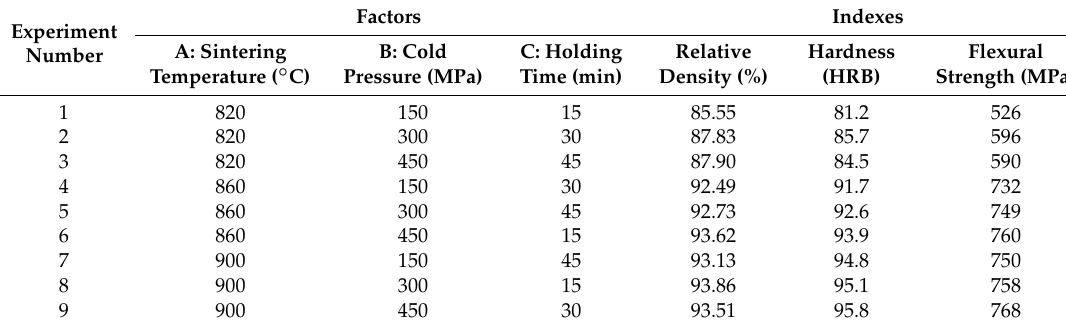
Table 2. The results of the orthogonal